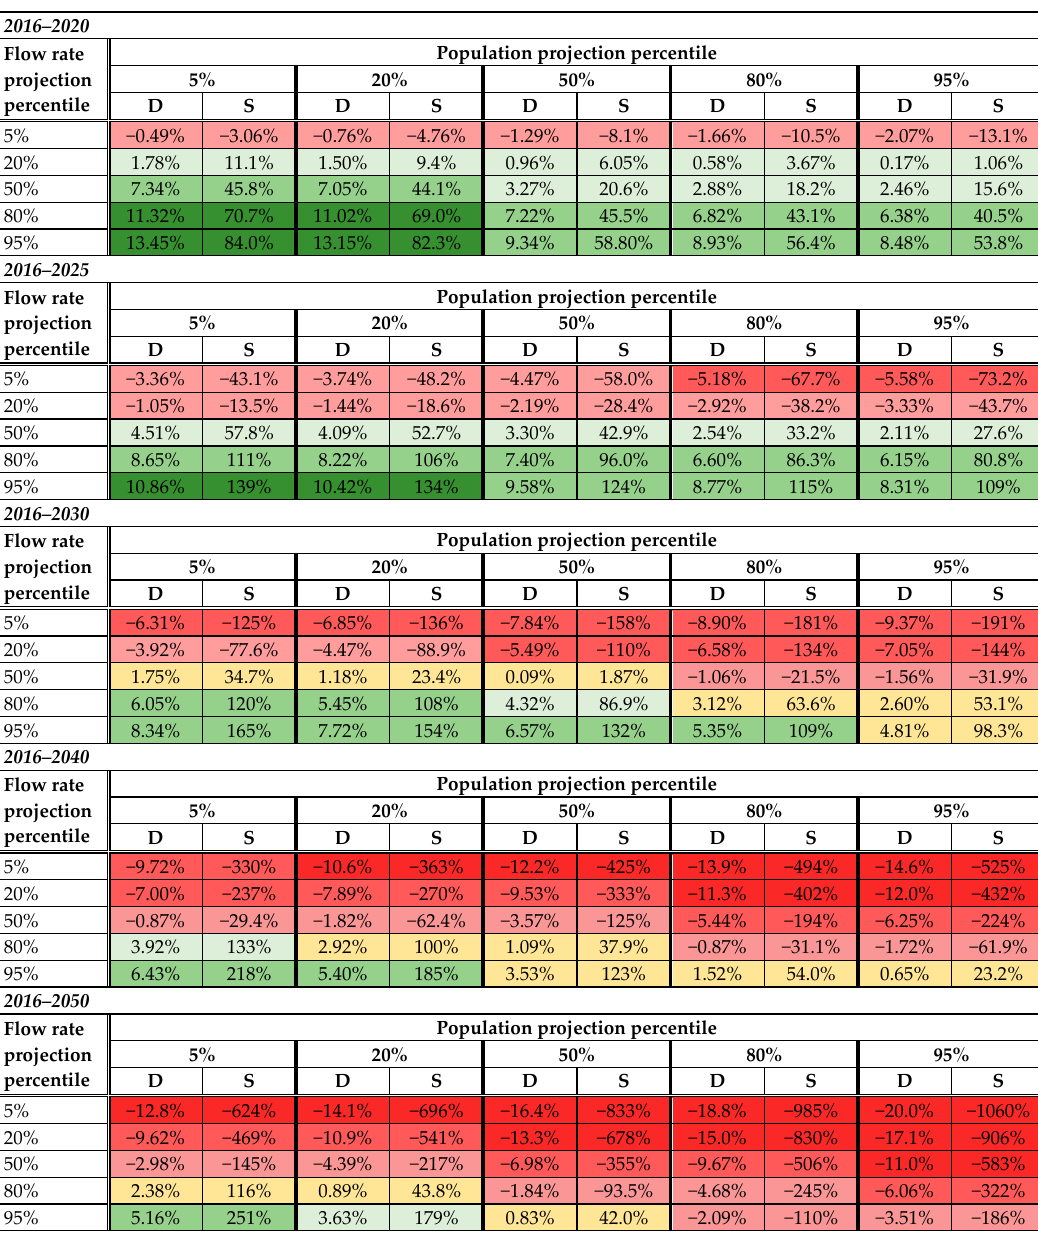
Figure 7. Total extra water available as a percentage of total demand (D) and storage capacity (S) for